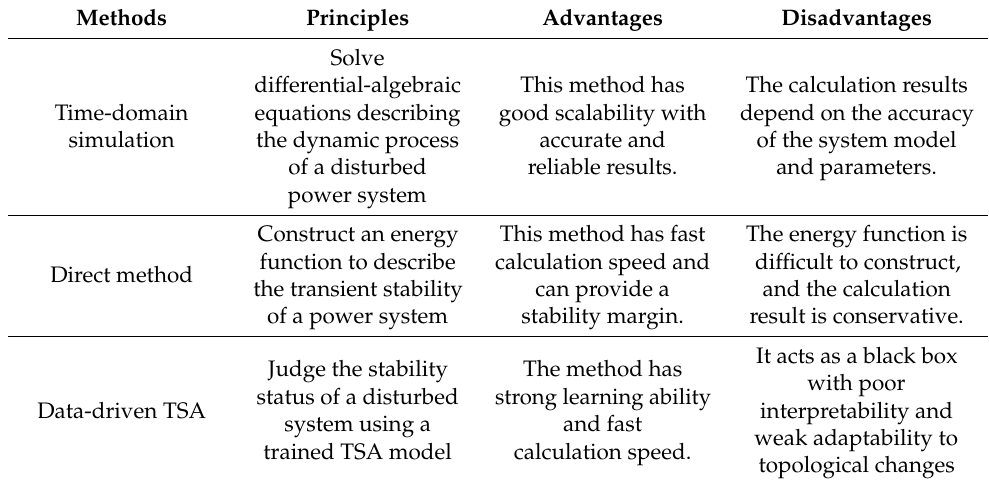
Table 1. Principles, advantages, and disadvantages of different TSA